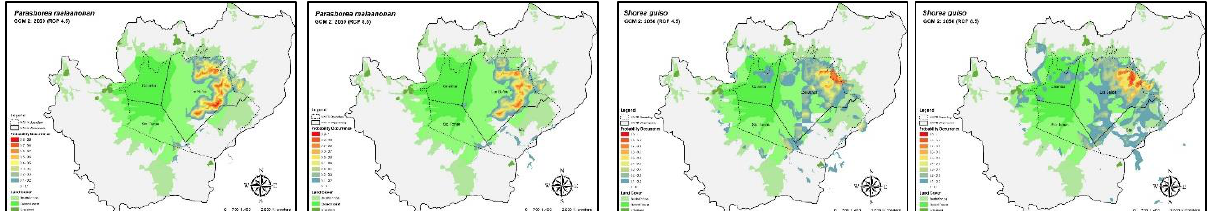
Figure 7. Predicted distribution of Parashorea malaanonan (L) and Shorea guiso (R) for GCM-1 by year 2070 under RCP 4.5 and RCP 8.5.